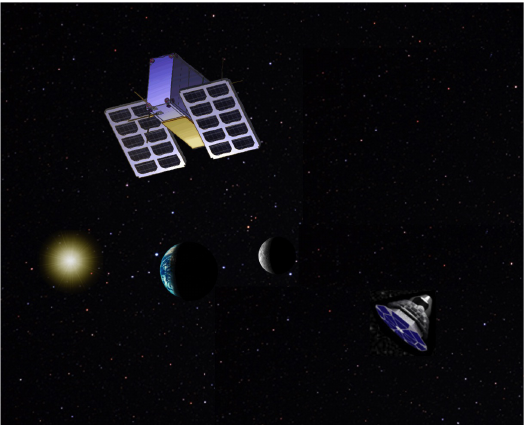
Figure 1. Artist’s view of two satellites in formation flying. Nearby to the left, L2-CalSat, the proposed calibration system hosted by a 6U CubeSat, while to the right and in the distance a space satellite for CMB polarization measurements is